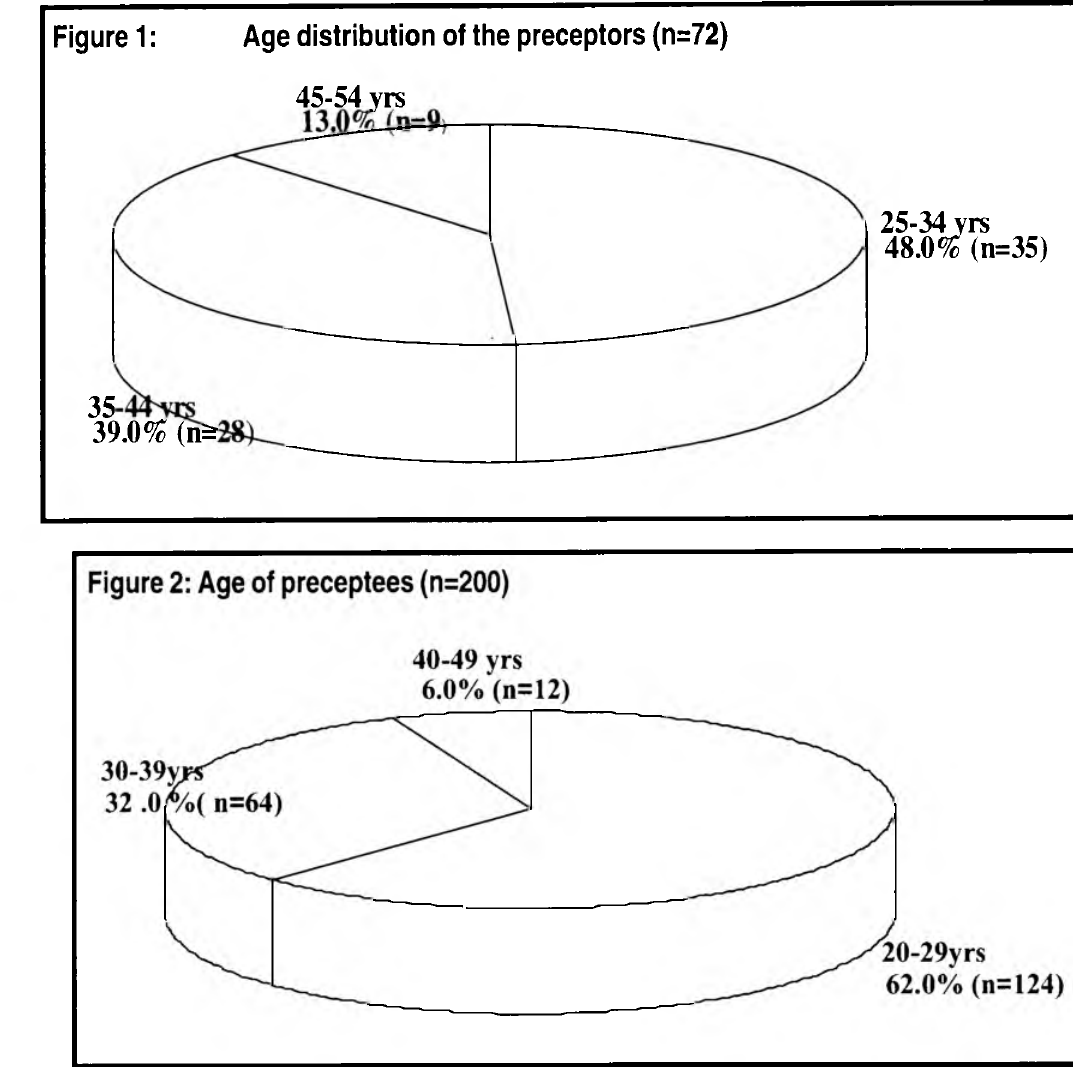
Figure 1: Age distribution of the preceptors